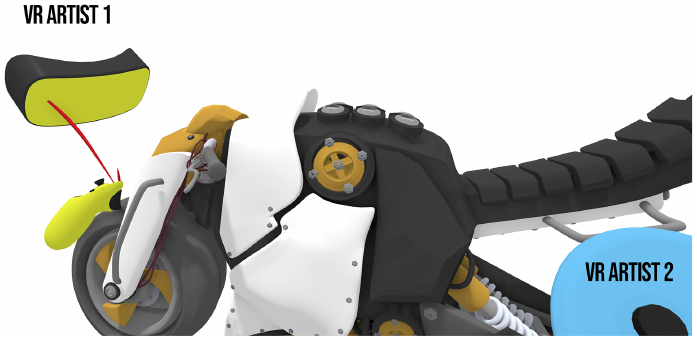
Figure 5. Two VR artists using co-creation tools inside Gravity Sketch.